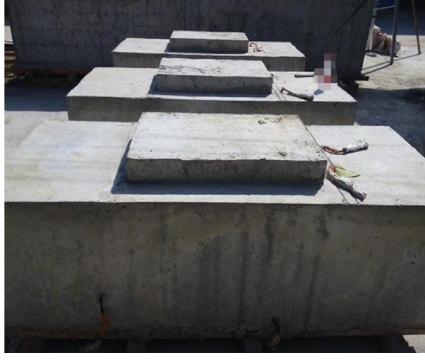
Figure 4: Experimental specimens. Table 1: Size of the specimen and diameter of stirrups.